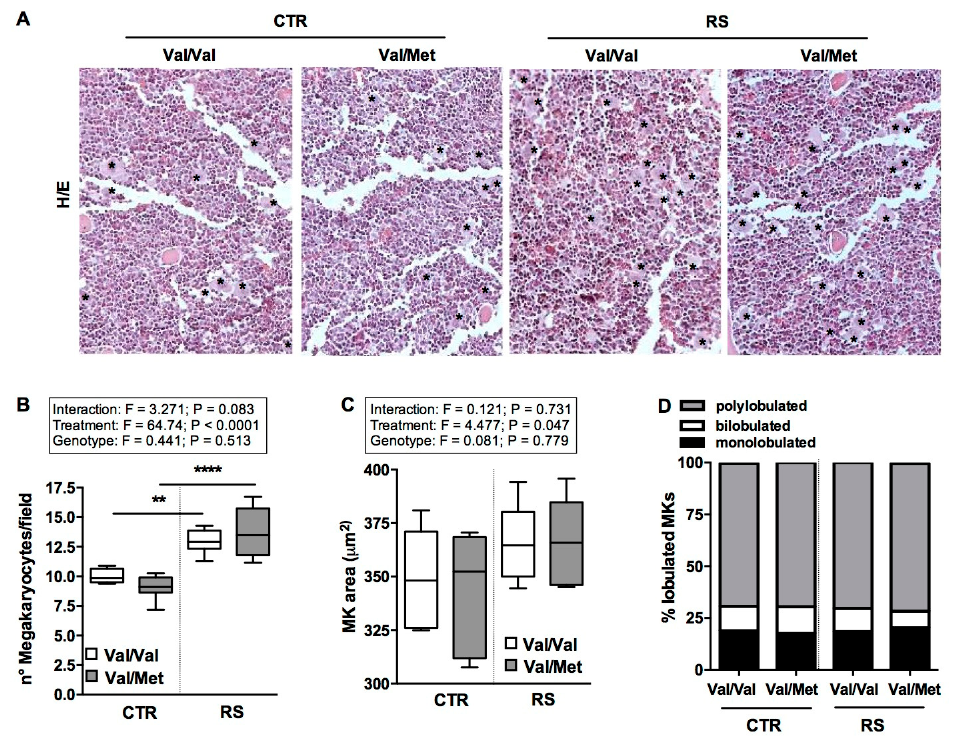
Figure 5. Effect of restraint stress on bone-marrow megakaryocytes. ( A ) Hematoxylin and Eosin (H&E) staining of bone marrow from stressed (RS) and not stressed (CTR) BDNF Val/Val and BDNF Val/Met mice. Asterisks indicate MKs. ( B ) Quantification of panel ( A ) expressed as megakaryocytes per field (40 × magnification). Analysis of ( C ) area and of ( D ) nuclear complexity in megakaryocytes. n = 8 mice/group. Two-way ANOVA followed by Bonferroni post hoc analysis, p values were obtained by using log-transformed variables. ** p < 0.01 and **** p < 0.001. For each box-plot, the center line illustrates the median and box limits indicate the 25th and 75th percentiles.